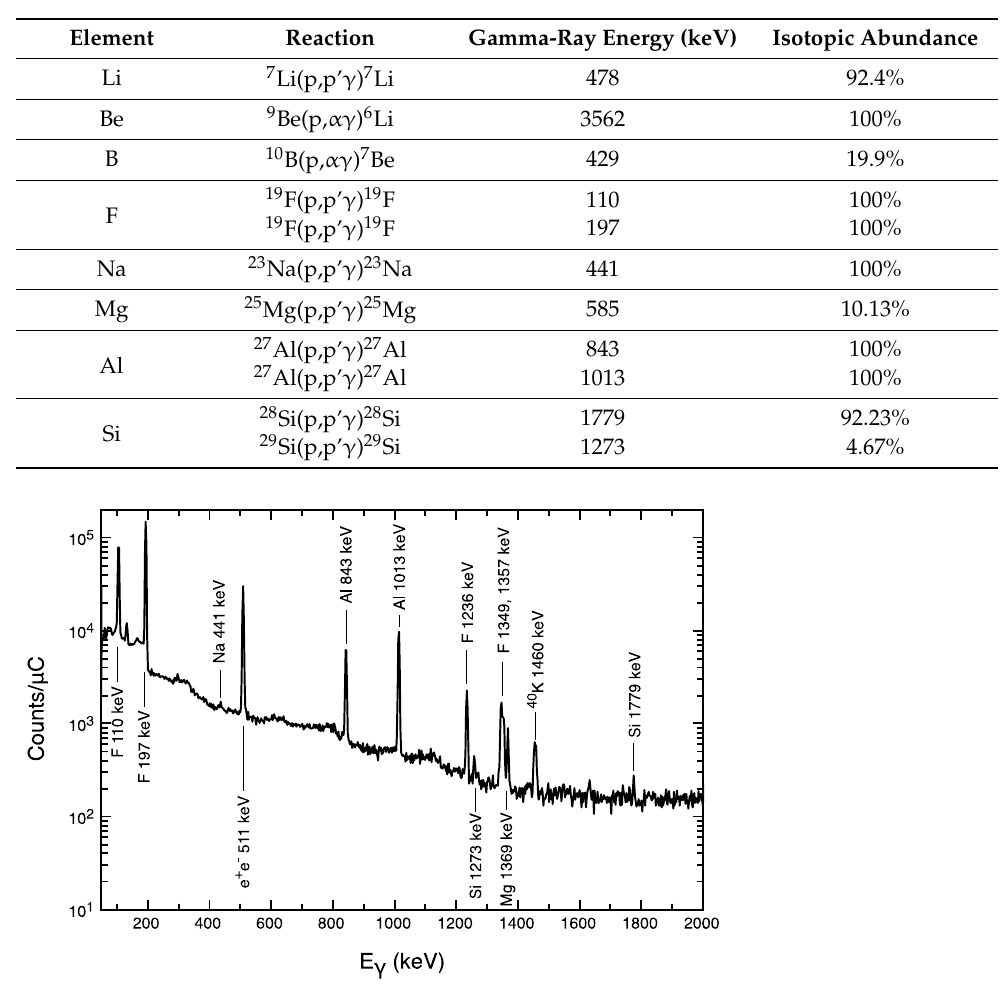
Table 1. Main PIGE reactions induced by protons of interest for elemental analysis in cultural heritage.